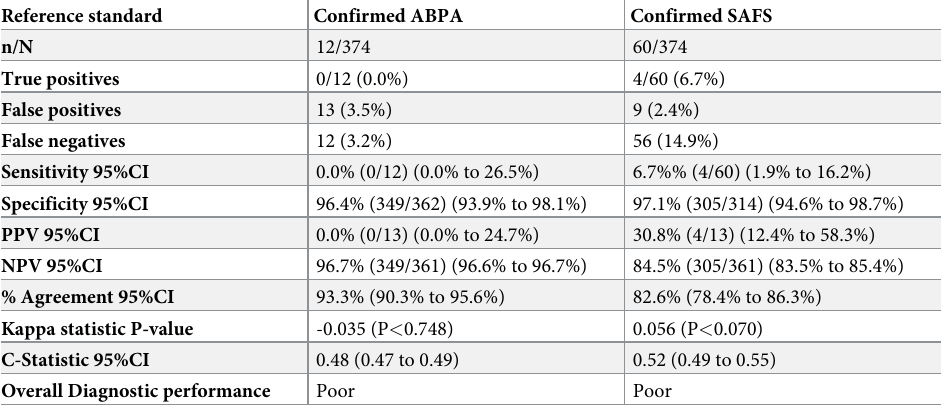
Table 3. Summary of diagnostic performance of LD Bio Aspergillus ICT IgG-IgM lateral flow assay for the diag- nosis of ABPA and